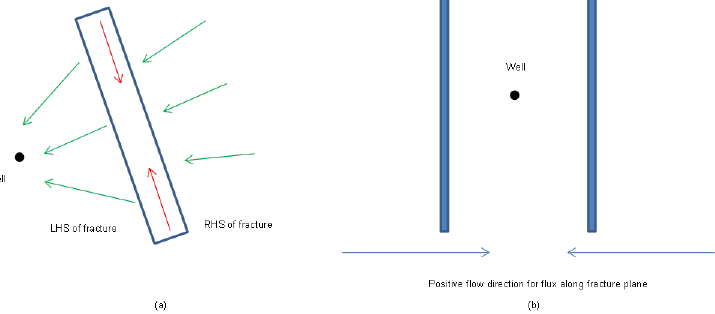
Figure 11. Definitions of ( a ) the LHS and the RHS of the isolated fracture faces and ( b ) the positive flow direction for flowing flux.